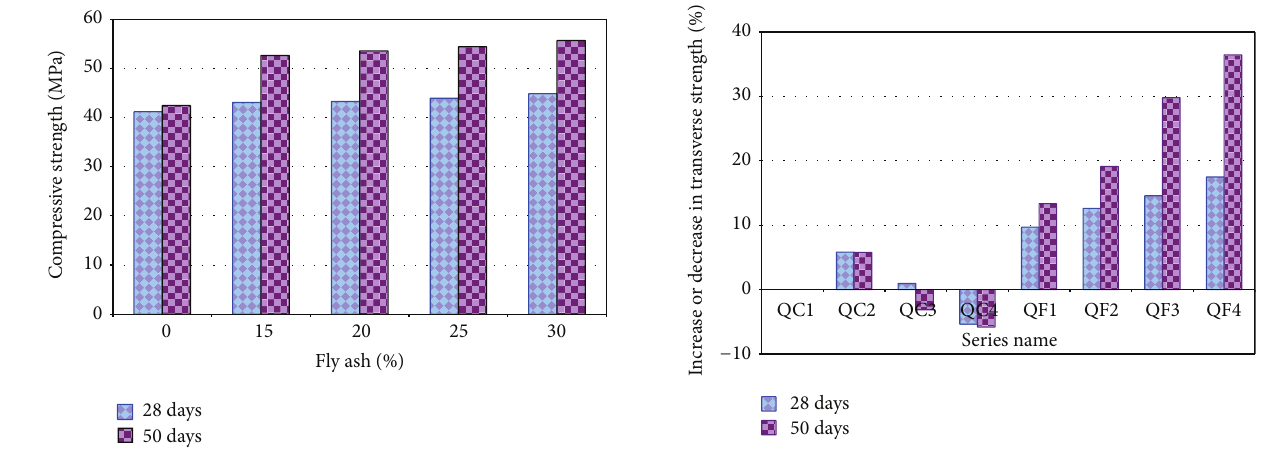
Figure6:Variationofcompressivestrengthwithvariouspercentage of fly ach replacement in cement.